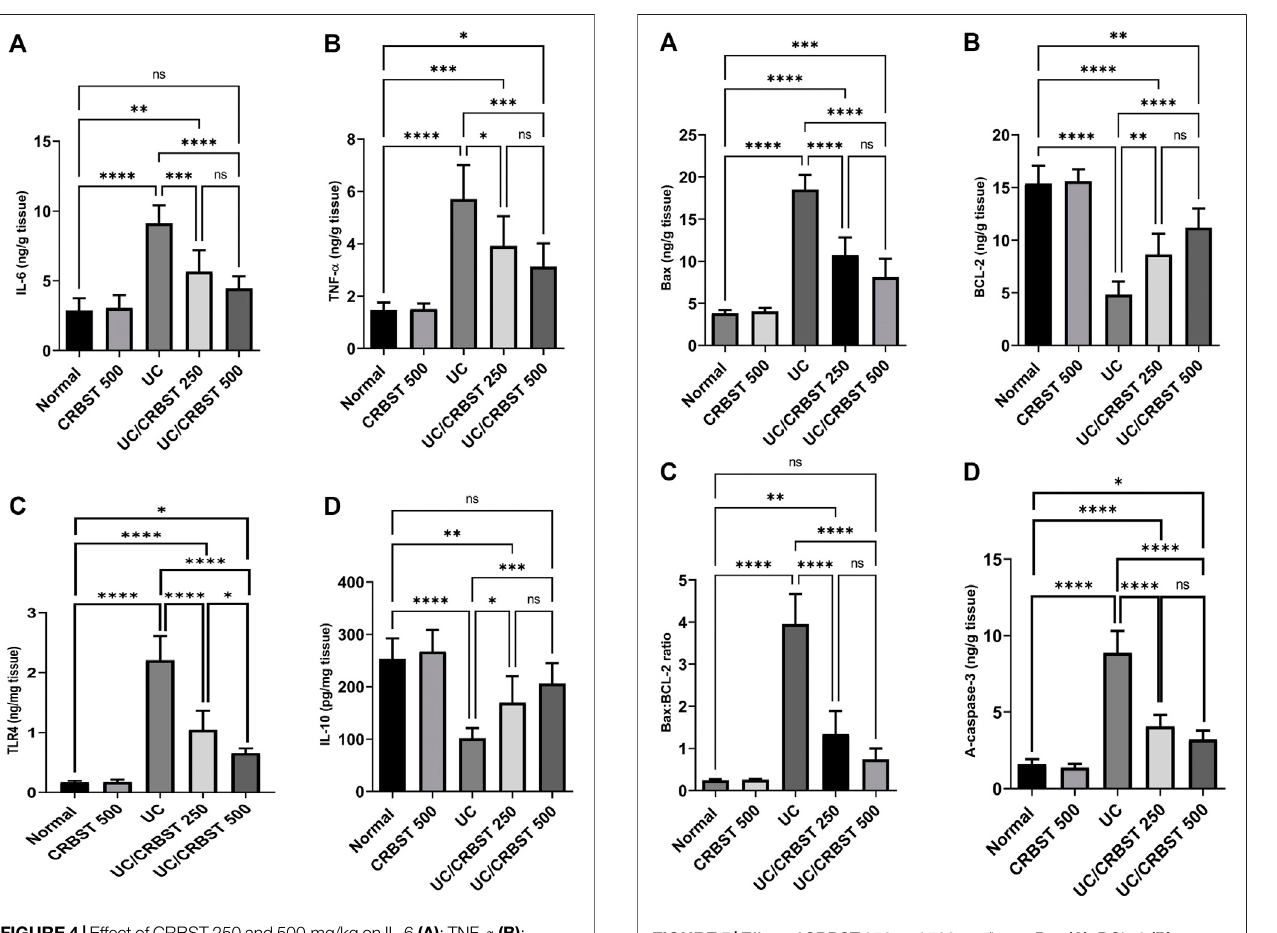
FIGURE5| EffectofCRBST250and500 mg/kgonBax (A) ;BCL-2 (B) ; Bax: BCL-2 ratio (C) and A-caspase-3 (D) in rats with AA-induced UC. Results are shown as the mean ± SD (n = 6). ** p < 0.01, *** p < 0.001, **** p < 0.0001. Normal, normal control rats administered the vehicle; CRBST 500, normal rats administered carbocisteine (500 mg/kg); UC, AA-induced UC rats administered the vehicle; UC/CRBST 250, AA-induced UC rats treatedwithcarbocisteine (250 mg/kg);UC/CRBST500,AA-induced UC rats treated with carbocisteine (500